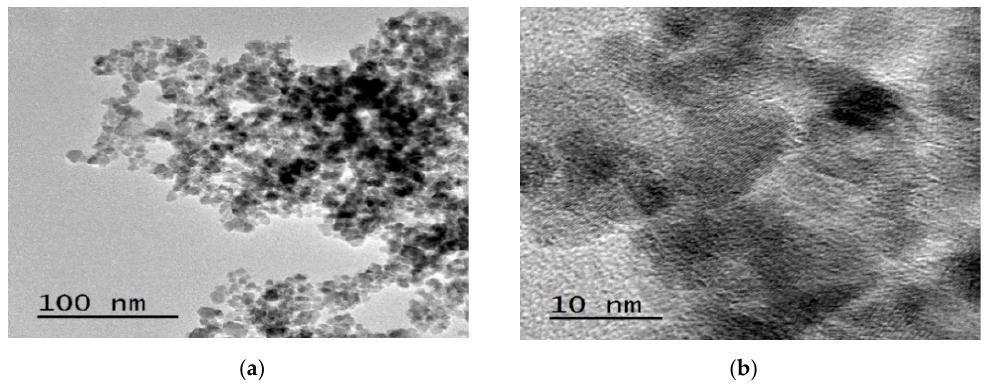
Figure 5. ( a ) TEM and ( b ) HRTEM images of MnV 0.1 Fe 1.83 O 4 prepared by hydrothermal processing at 180 °C.